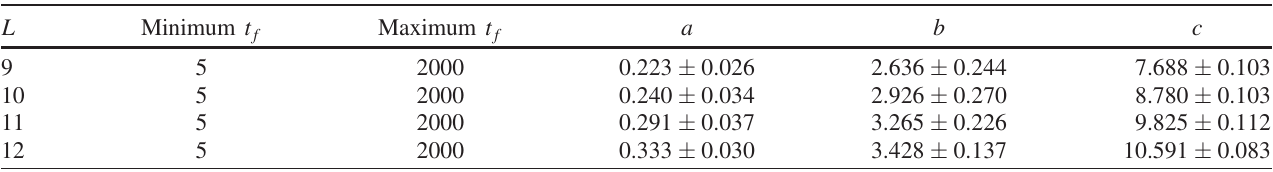
TABLE X. Fit to y ¼ a ð x − b Þ 2 þ c for the median results of the hardware-planted instances using the DW2X with y ¼ log TTS and x ¼ log t . f